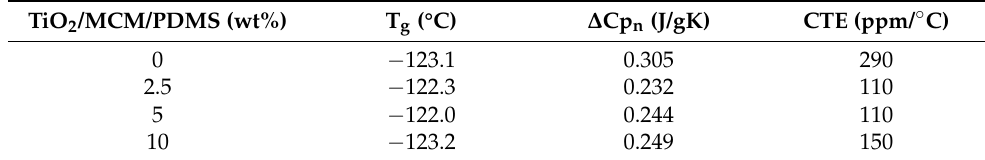
Figure 5. DSC curves of PDMS composites at various TiO 2 /MCM wt%. Table 1. Thermal properties of TiO 2 /MCM/PDMS composites.